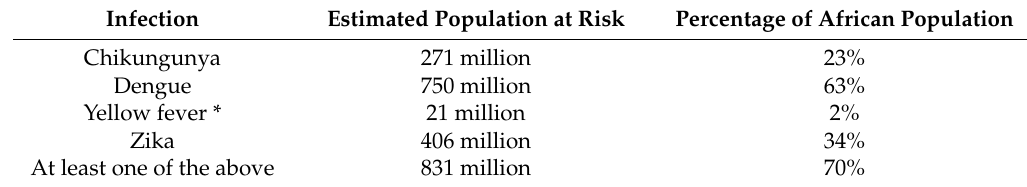
Table 1. Estimated population at risk of infection (PAR) by each arbovirus and by overlapping arboviruses in Africa, 2015. Population estimates were calculated using the methods and data sources as defined and cited in Figure 1a,b, respectively. Estimated Population at Risk